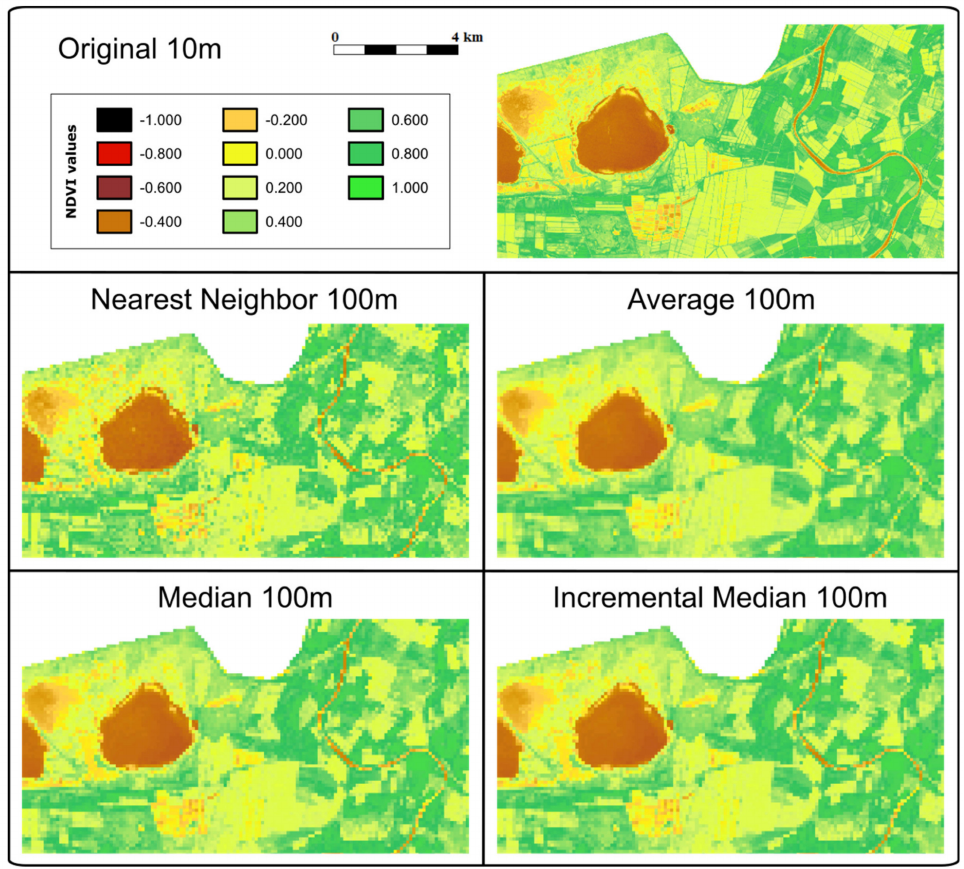
Figure 9. Detail of the 20 / 04 / 2018 NDVI of the Camargue PA at original 10 m and 100 m resolution using four resampling methods. The scale and legend shown for the original images apply to all of